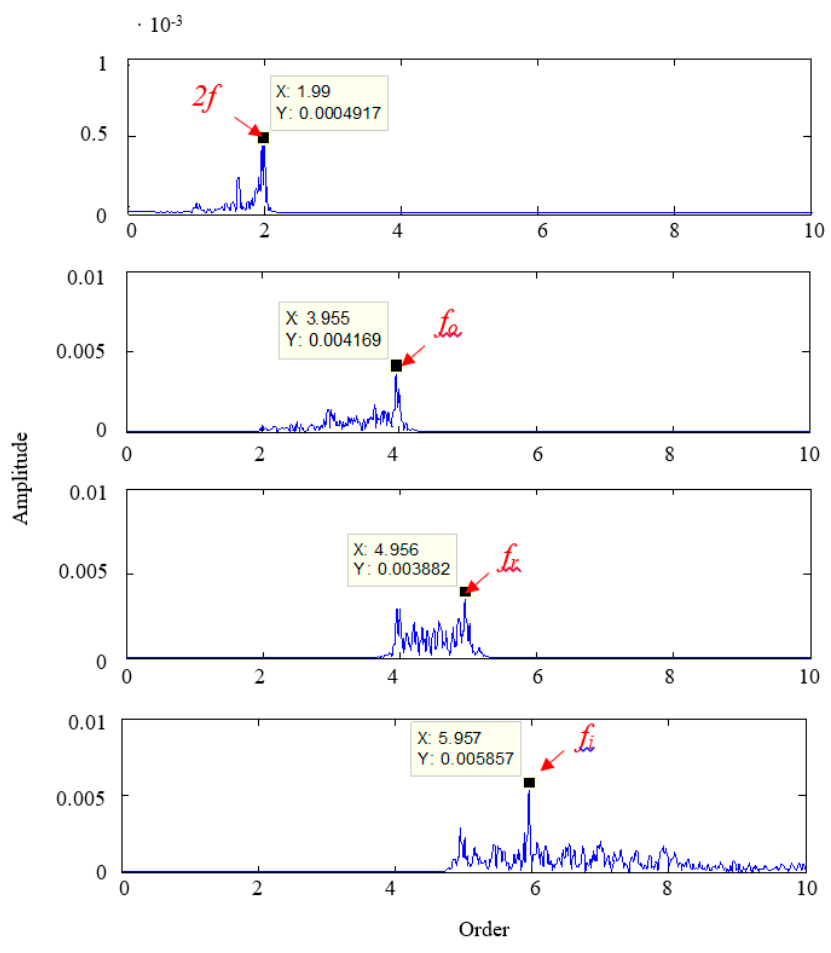
Figure 12. The corresponding envelope order spectrums of extracted modes by